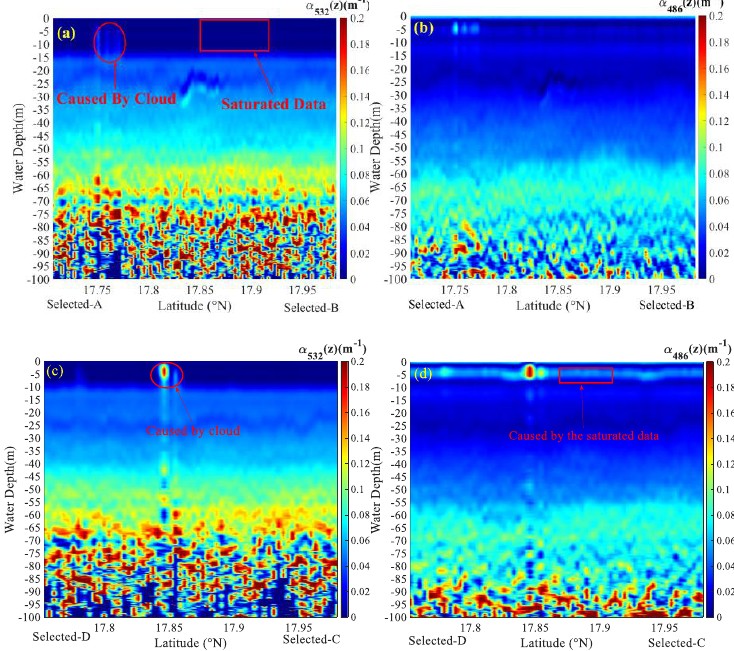
Figure 18. ( a ) Distribution of α 532 ( z ) from Selected-A to Selected-B; ( b ) distribution of α 486 ( z ) from Selected-A to Selected-B; (c) distribution of α 532 ( z ) from Selected-C to Selected-D; ( d ) distribution of α ( z ) from Selected-C to Selected-D. The three-dimensional vertical profile distribution of are shown in Figure 19.